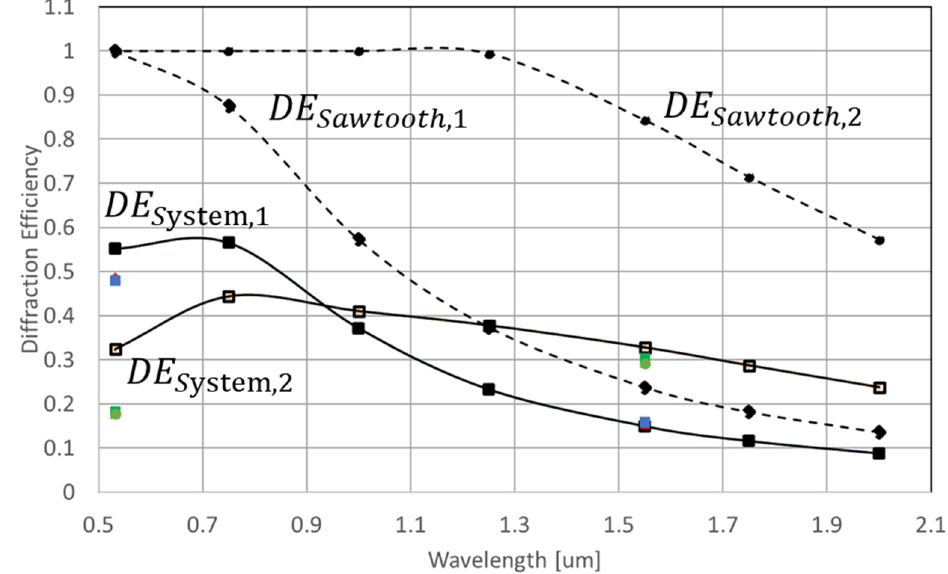
Figure 9. System diffraction efficiency of single modulation ( 𝐷𝐸 (cid:3020)(cid:3052)(cid:3046)(cid:3047)(cid:3032)(cid:3040),(cid:3036)(cid:2880)(cid:2869) ) and dual modulation ( 𝐷𝐸 (cid:3020)(cid:3052)(cid:3046)(cid:3047)(cid:3032)(cid:3040),(cid:3036)(cid:2880)(cid:2870) ) is plotted as a function of wavelength and is a product of the system transmission ( 𝑇 (cid:3036)(cid:2880)(cid:2869) and 𝑇 (cid:3036)(cid:2880)(cid:2870) in Figure 7) and theoretical diffraction efficiency of single- ( 𝐷𝐸 (cid:3020)(cid:3028)(cid:3050)(cid:3047)(cid:3042)(cid:3042)(cid:3047)(cid:3035),(cid:2869) ) and dual- phase modulation (( 𝐷𝐸 (cid:3020)(cid:3028)(cid:3050)(cid:3047)(cid:3042)(cid:3042)(cid:3047)(cid:3035),(cid:2870) ). The green and blue square dots show measured diffraction efficiency of dual and single modulation, respectively.